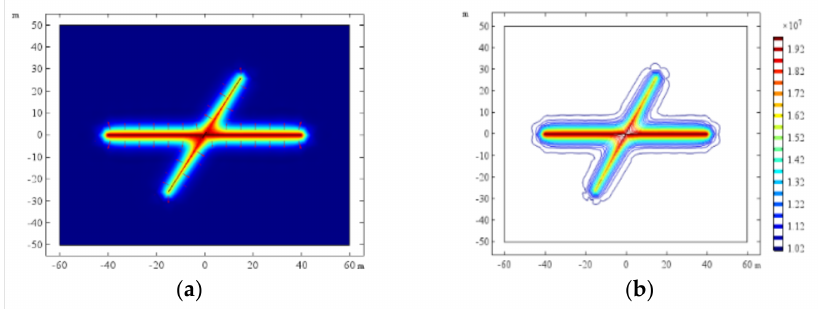
Figure 5. Case 2 calculation result. ( a ) Grout propagation pattern. ( b ) Distribution of grout propaga- tion pressure field.